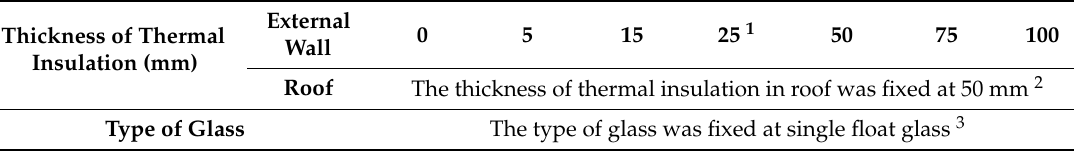
Table 12. Variation in the thickness of thermal insulation of the external wall.